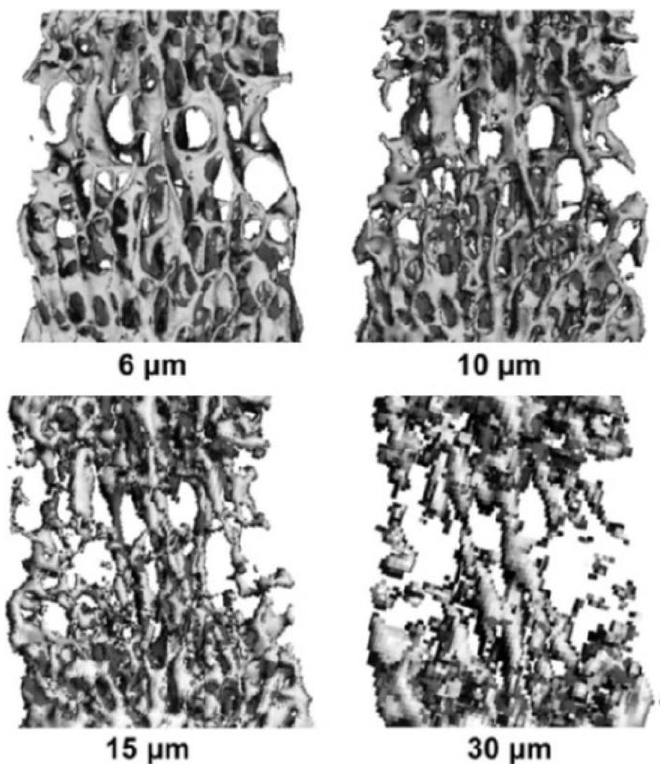
Figure 12. Effect of scanning voxel size on the trabecular interconnectivity of the same vertebral body. Image obtained from the work of Christiansen et al. [68] and licensed under a Creative Commons Attribution 4.0 International Licence.